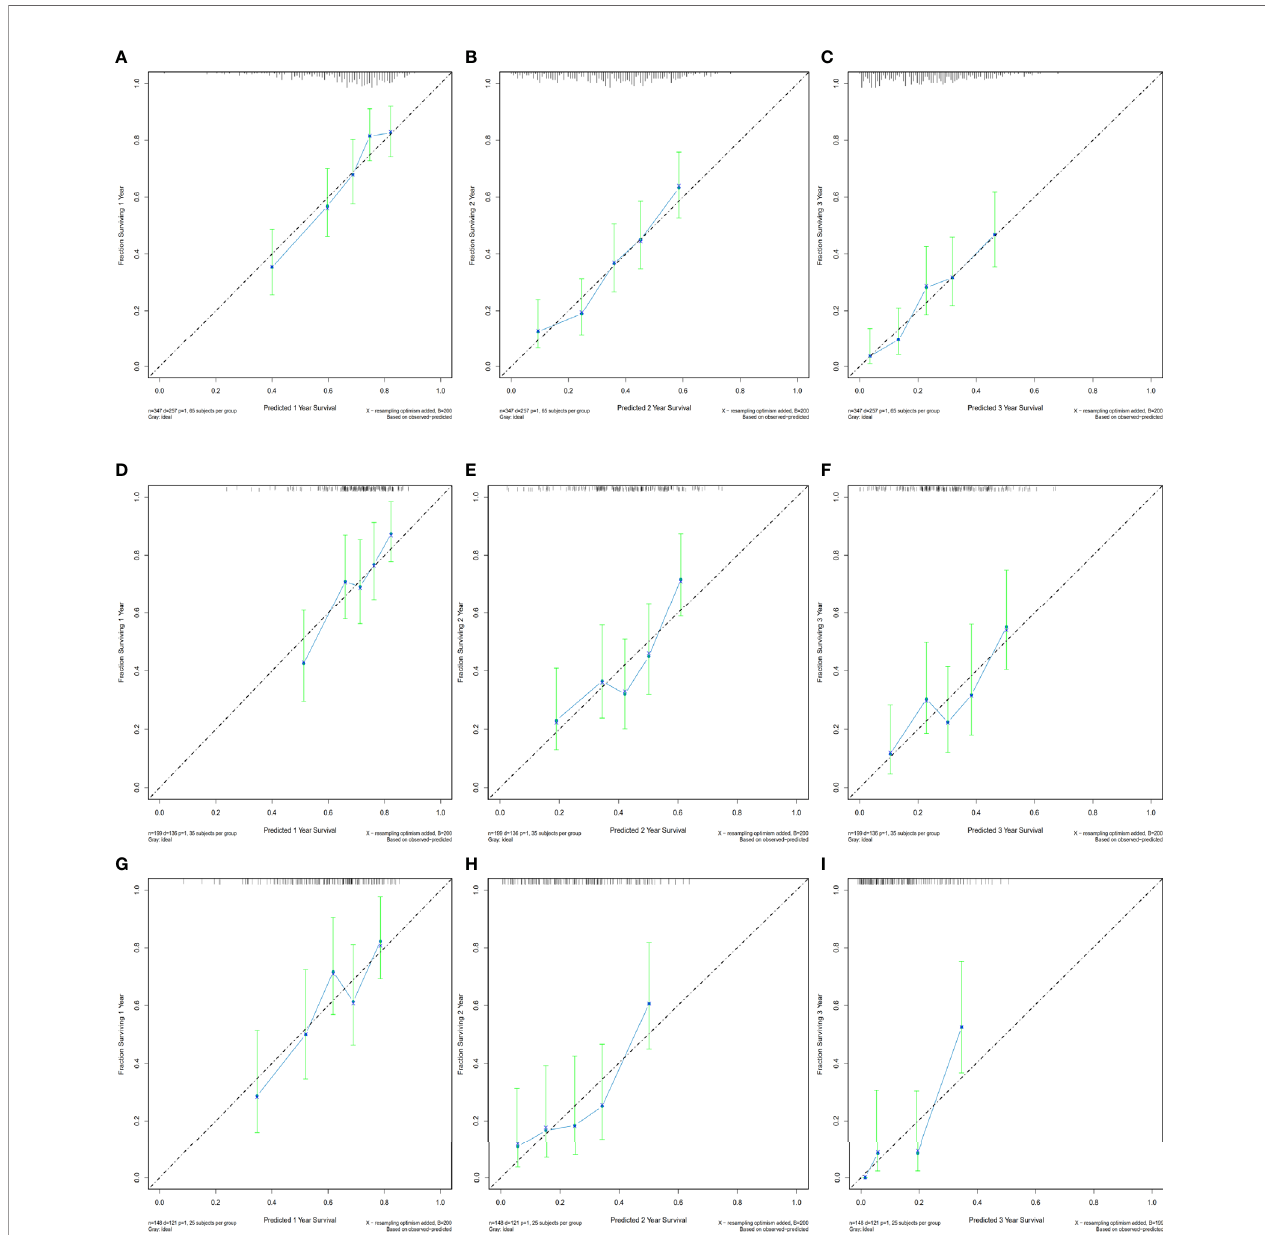
FIGURE 4 | Bootstrap calibration of nomograms in the test cohorts. The nomograms were externally validated in the test cohorts by predicting (A) 1-year CSS, (B) 2-year CSS, and (C) 3-year CSS in the PDAC group; (D) 1-year CSS, (E) 2-year CSS, and (F) 3-year CSS in the PHC group; and (G) 1-year CSS, (H) 2-year CSS, and (I) 3-year CSS in the PBTC group. All results showed good